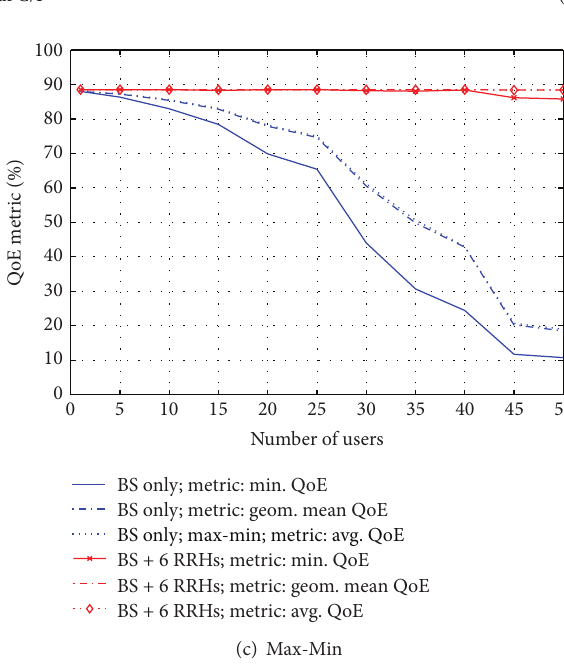
Figure 6: DL QoE results with